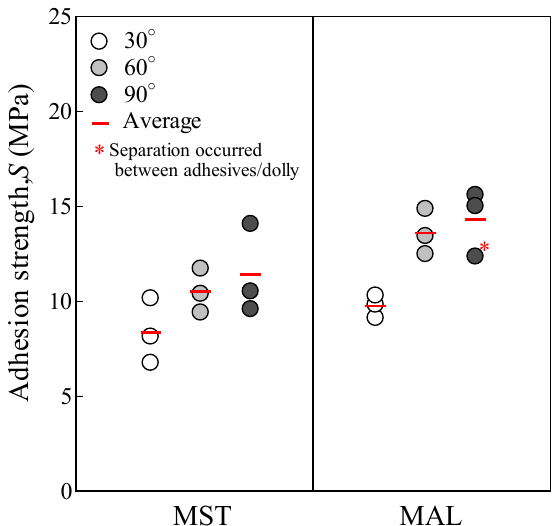
Figure 5. The results of adhesion strength.